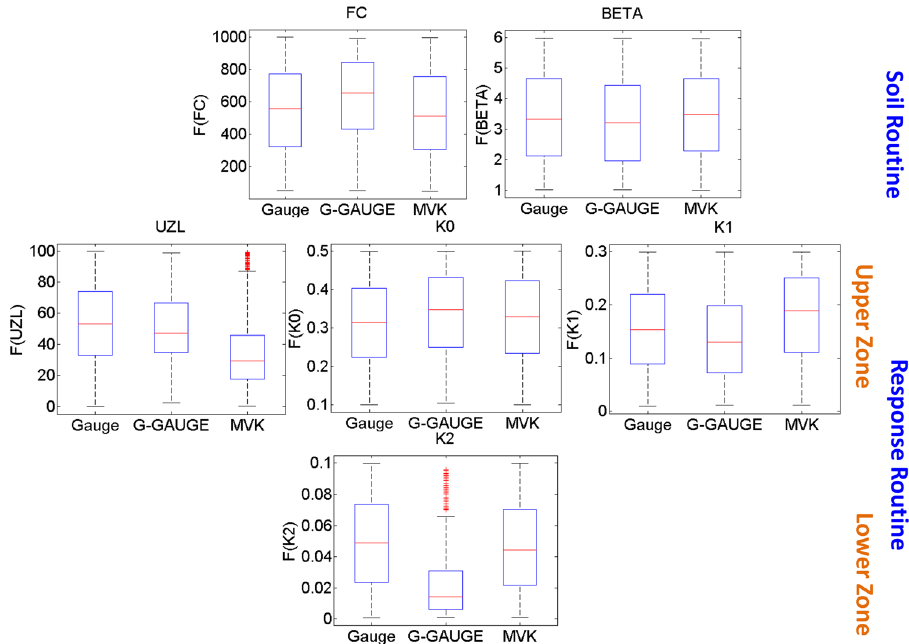
Fig. 9 Box plots of 6